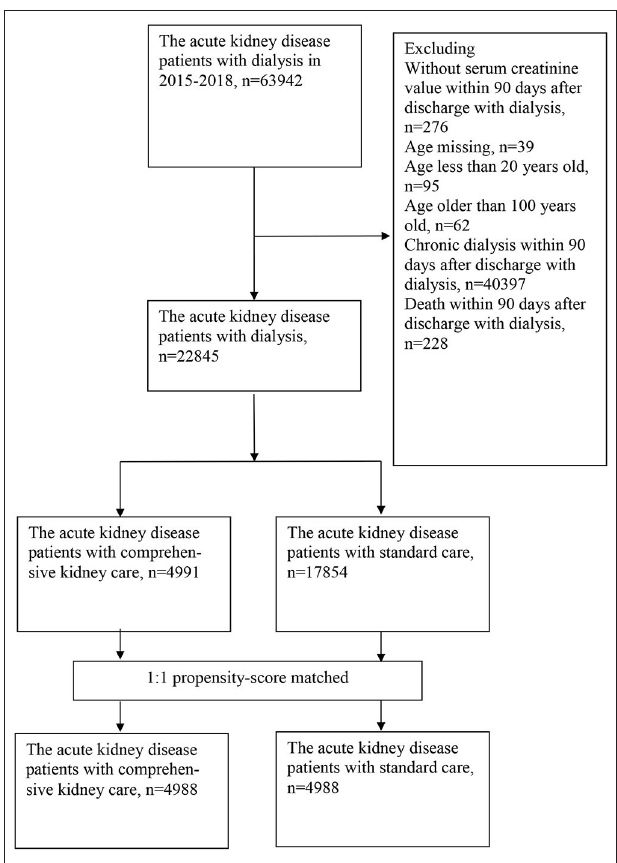
FIGURE 1 | Flow chart of patient